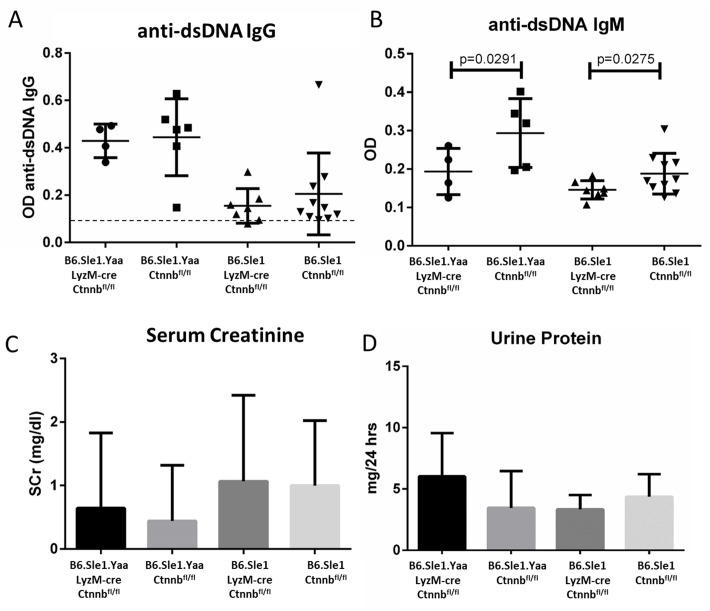
LyzM-cre-mediated β-catenin knockout does not affect lupus pathogenesis.B6 mice were bred to produce mice expressing the lupus-susceptibility locus Sle1, the lupus-accelerating locus Yaa (males only), and β-catenin-floxed loci in the presence or absence of the LyzM-cre locus. Mice expressing all of these loci are genetically lupus-prone and lack macrophage β-catenin expression. Mice expressing all but the LyzM-cre locus are sibling controls. Mice lacking macrophage β-catenin exhibit similar levels of anti-dsDNA IgG (A) but significantly lower levels of anti-dsDNA IgM (B). These mice did not exhibit significantly different markers of kidney function as measured by serum creatinine (C) and urine protein (D).